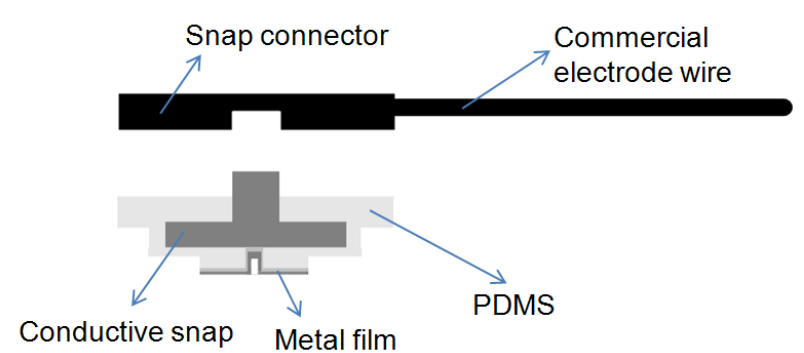
Figure 2. The wire connection method of